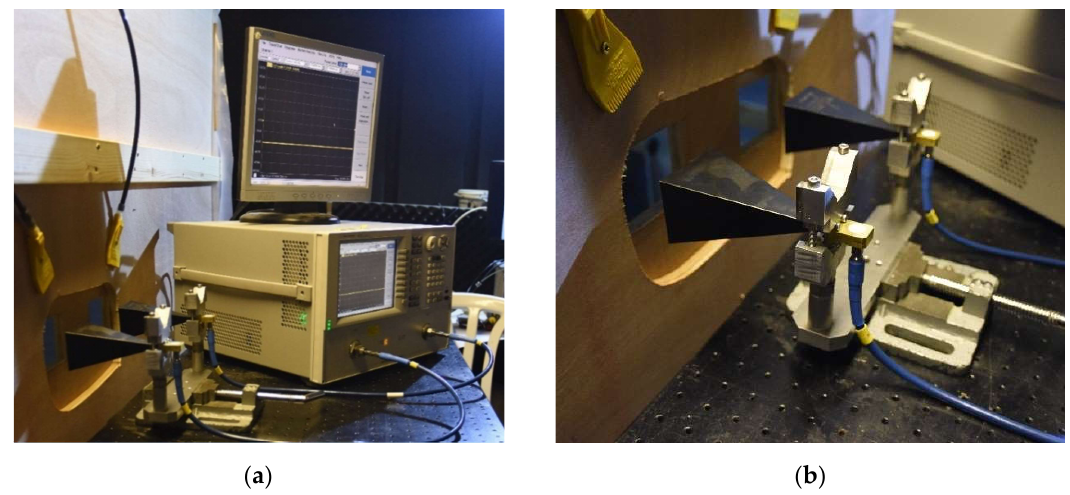
Figure 9. Experiment system: ( a ) the Network Analyzer connected to two horn antennas outside the chamber; ( b ) the horn antennas.